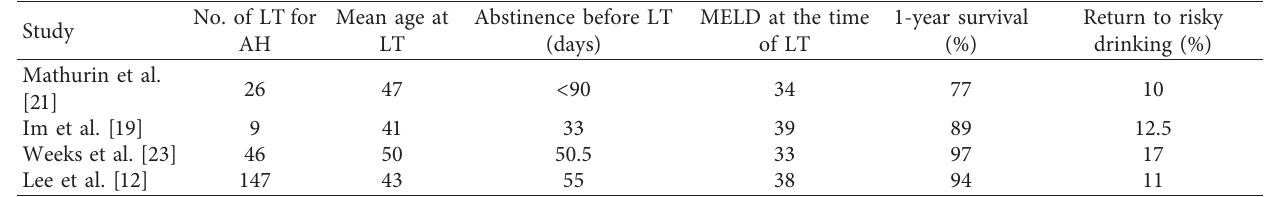
Table 2: Studies comparing patients with severe alcoholic hepatitis (AH) undergoing liver transplantation.